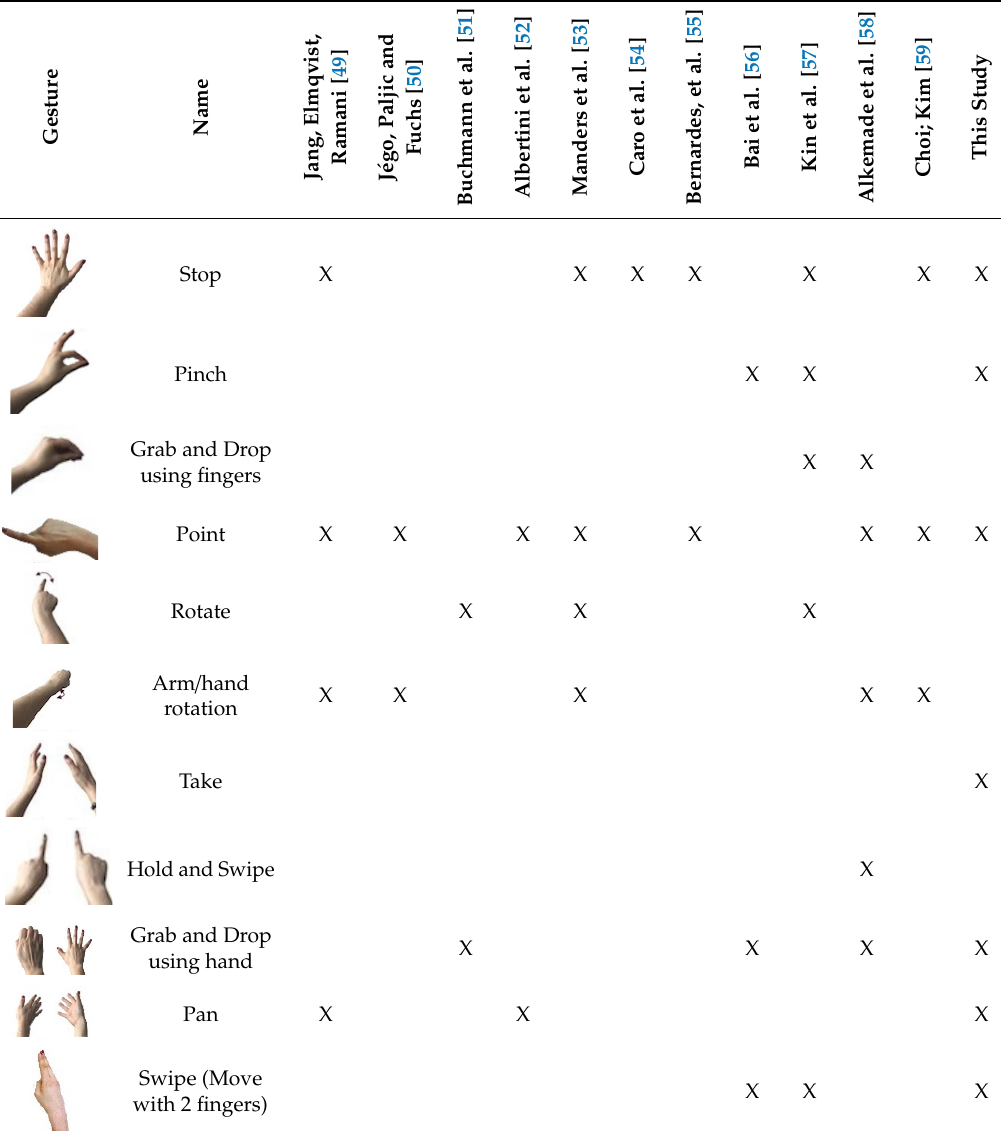
Table 1. Gestures identified from bibliography review.